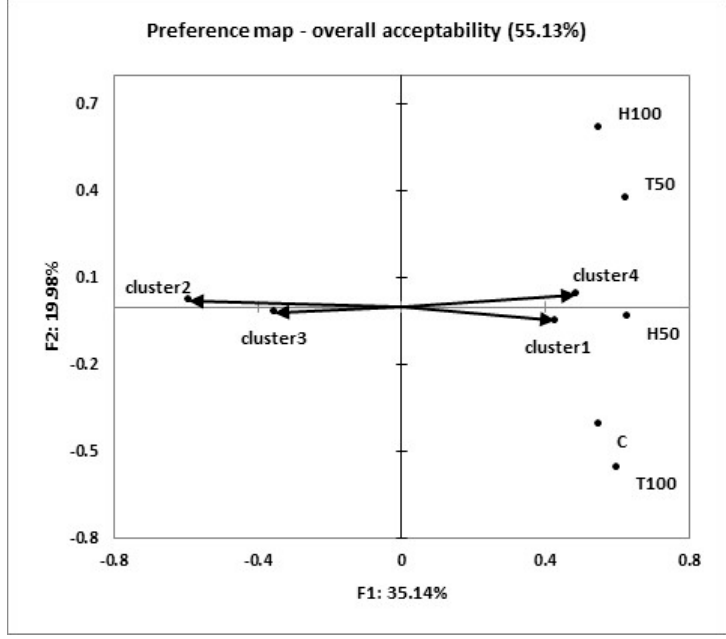
Figure 2. Internal preference map of the overall acceptability. Each preference vector ( → ) represents a cluster group of the panelist. Note: C = control diet; H = Hermetia illucens fat; T = Tenebrio molitor oil.